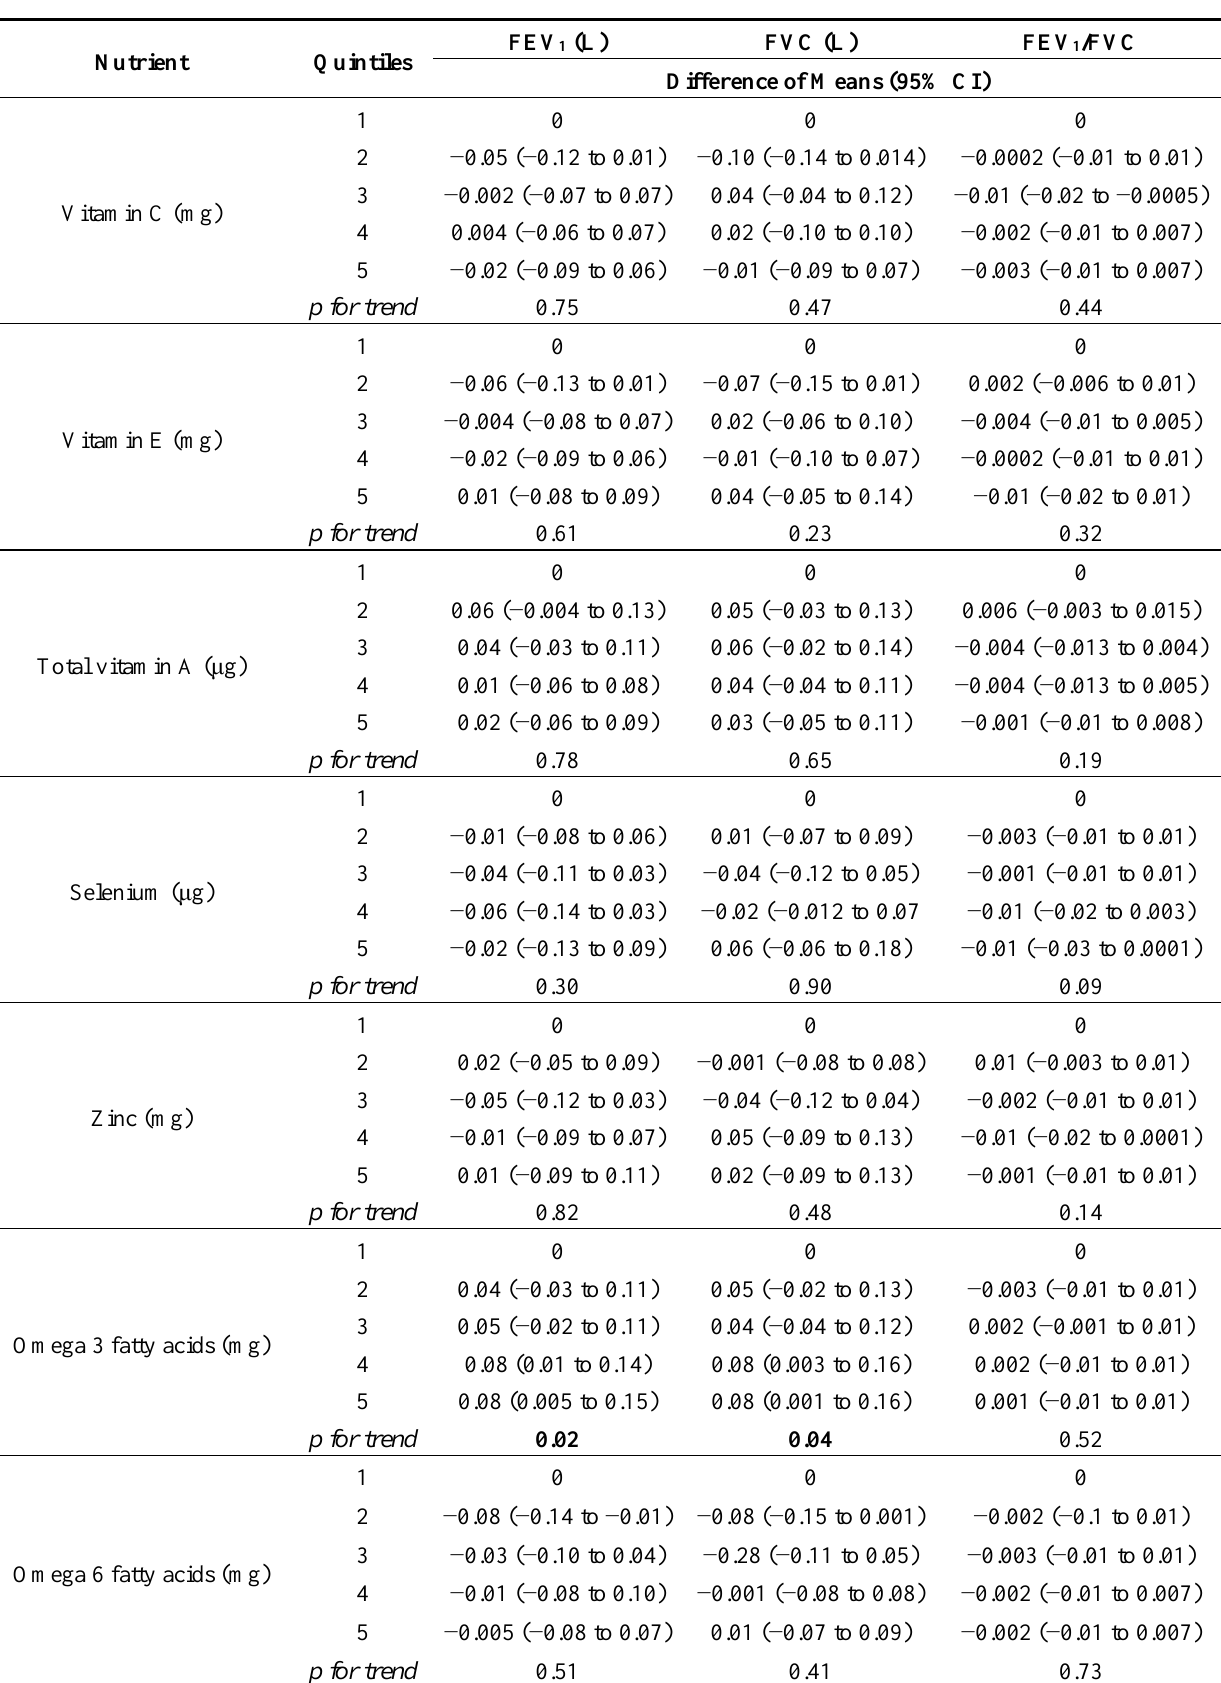
Table 3. The association between components of ventilatory function and estimated daily nutrient and antioxidant intake